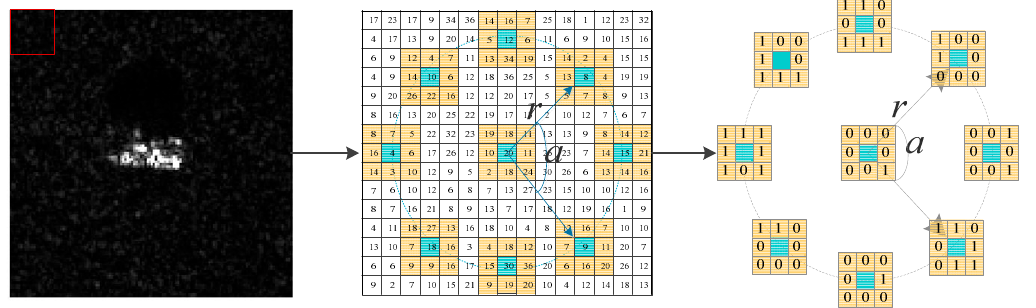
Figure 4. The TPLBP code of BMP2 ( S = 8, w = 3, α =